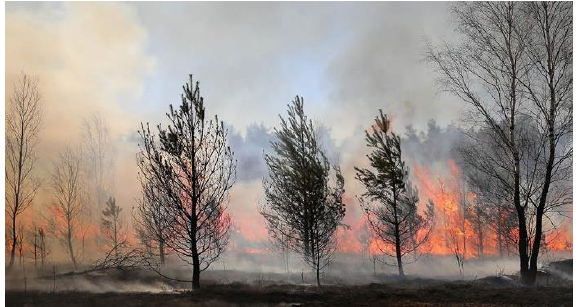
Figure 2: Increasing risk for Wildfires (Remote Sensing